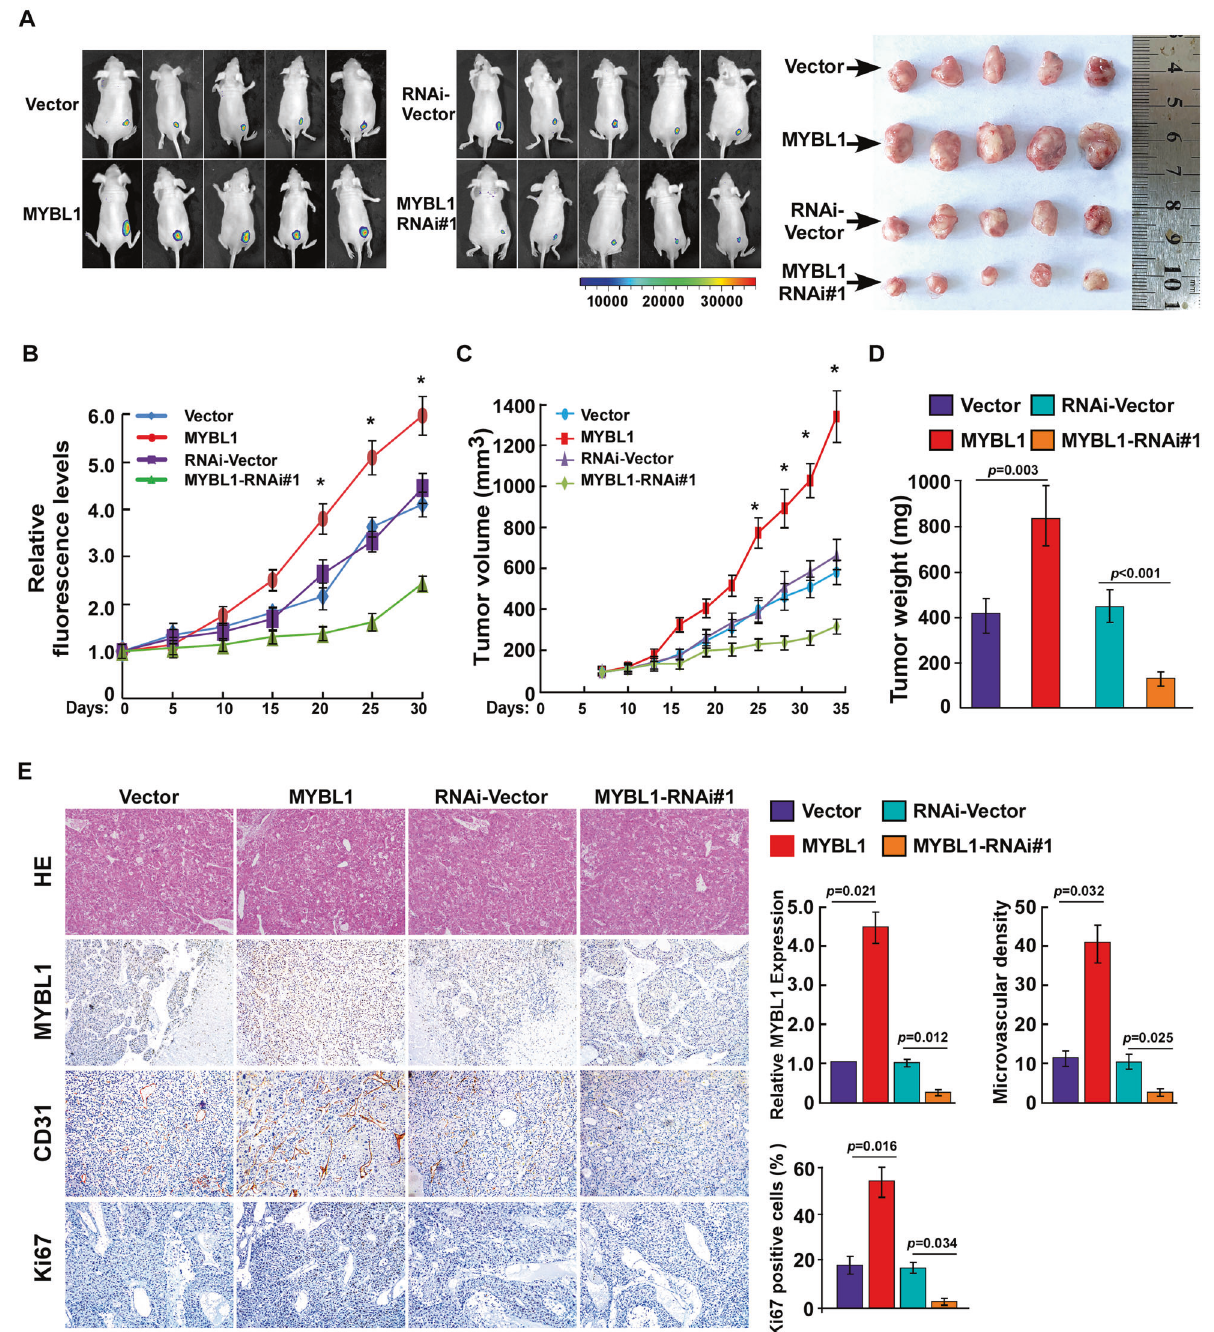
Fig. 3 MYBL1 promotes HCC angiogenesis in vivo. A HCC cells were subcutaneous injected into nude mice ( n = 5/group). Fluorescence signal of nude mice was measured (right). Representative images of tumor-bearing mice; Images of the tumors from all mice in each group (left). B Quanti fi cation of fl uorescence signal was measured on the indicated days. C Tumor volumes of nude mice from the indicated group were measured. D Tumor weights of nude mice from the indicated group were measured. E H&E, Ki67and CD31 staining was performed in the indicated group. Each bar represents the mean ± SD of three independent (Fig. 3E), suggesting that MYBL1 contributes to HCC angiogenesis in vivo. Furthermore, the transwell matrix penetration assay showed that MYBL1 enhanced the capacity of migrated and invasive of HCC cells than vector control cells, whereas MYBL1-inhibited cells had a lower migrated and invasive capacity (Supplementary Fig. S1B, C). Collectively, the above dates strongly suggest a vital role of MYBL1 as an angiogenesis inducer and promoted motility and invasiveness in HCC cells.